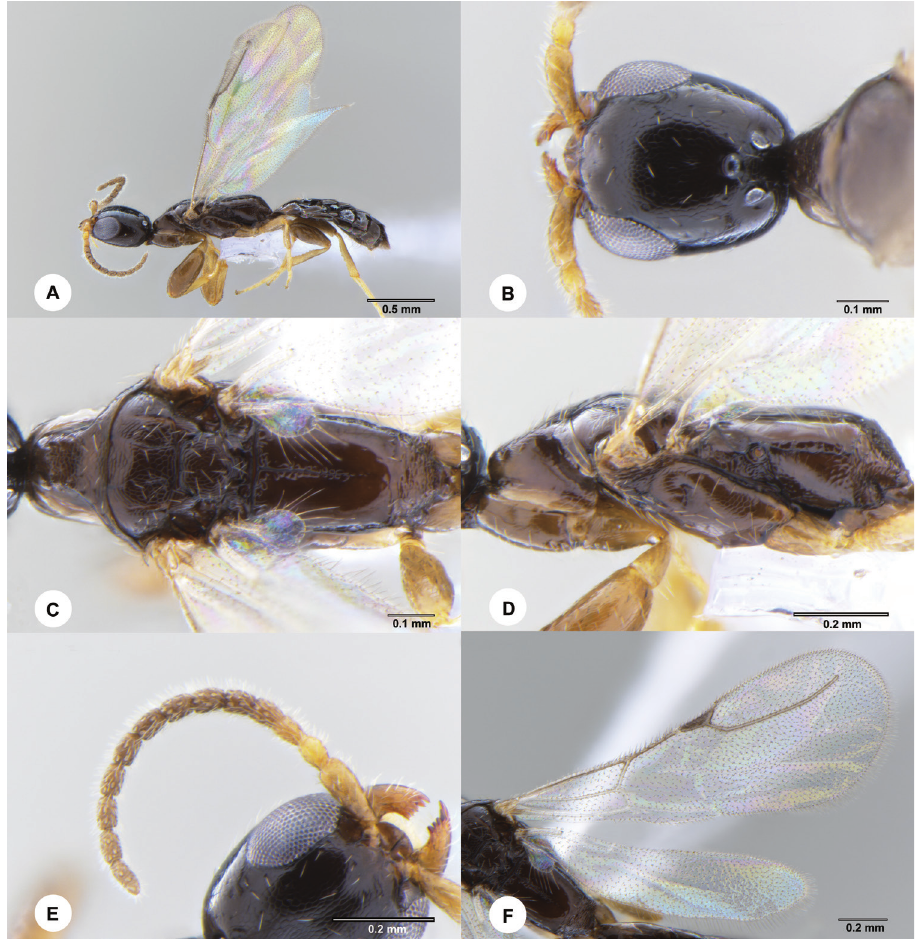
Figure 4. Foenobethylus xinglongensis Wang & Chen, sp. nov., male, holotype (SCAU 3042798) A lateral habitus B head, dorsal view C mesosoma, dorsal view D mesosoma, lateral view E antenna F